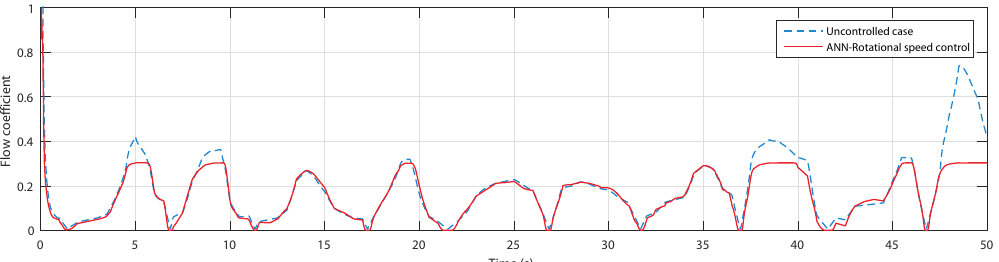
Figure 28. Flow coefficients for uncontrolled case and ANN-based rotational speed control.